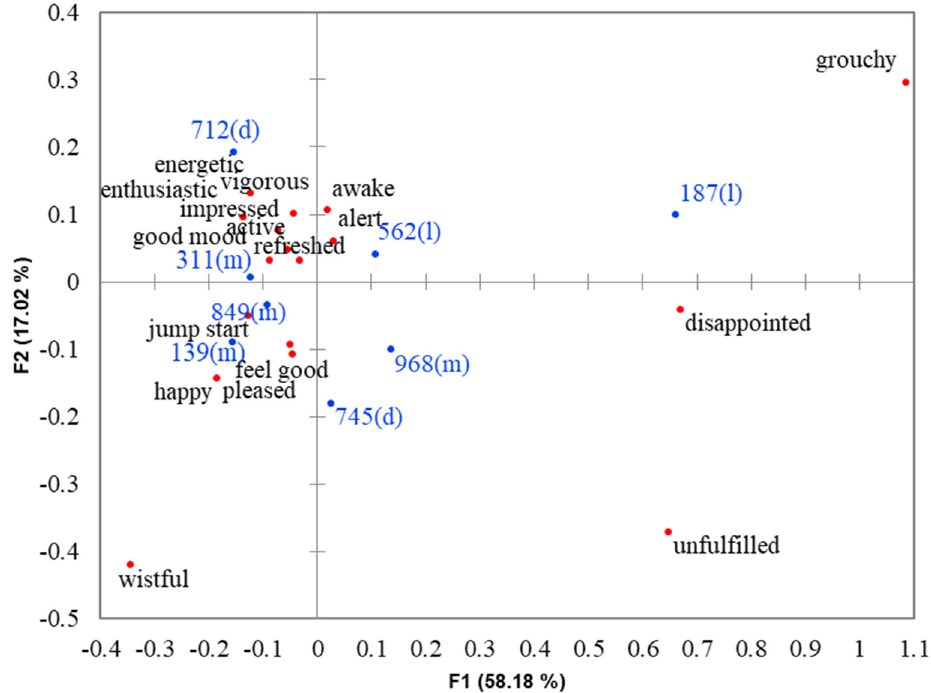
Figure 2. Correspondence analysis (CA) map showing the positioning of eight brewed black coffee samples in the emotion space. • = emotion terms, • = samples with roast level in parenthesis (l = light, m = medium and d = dark).